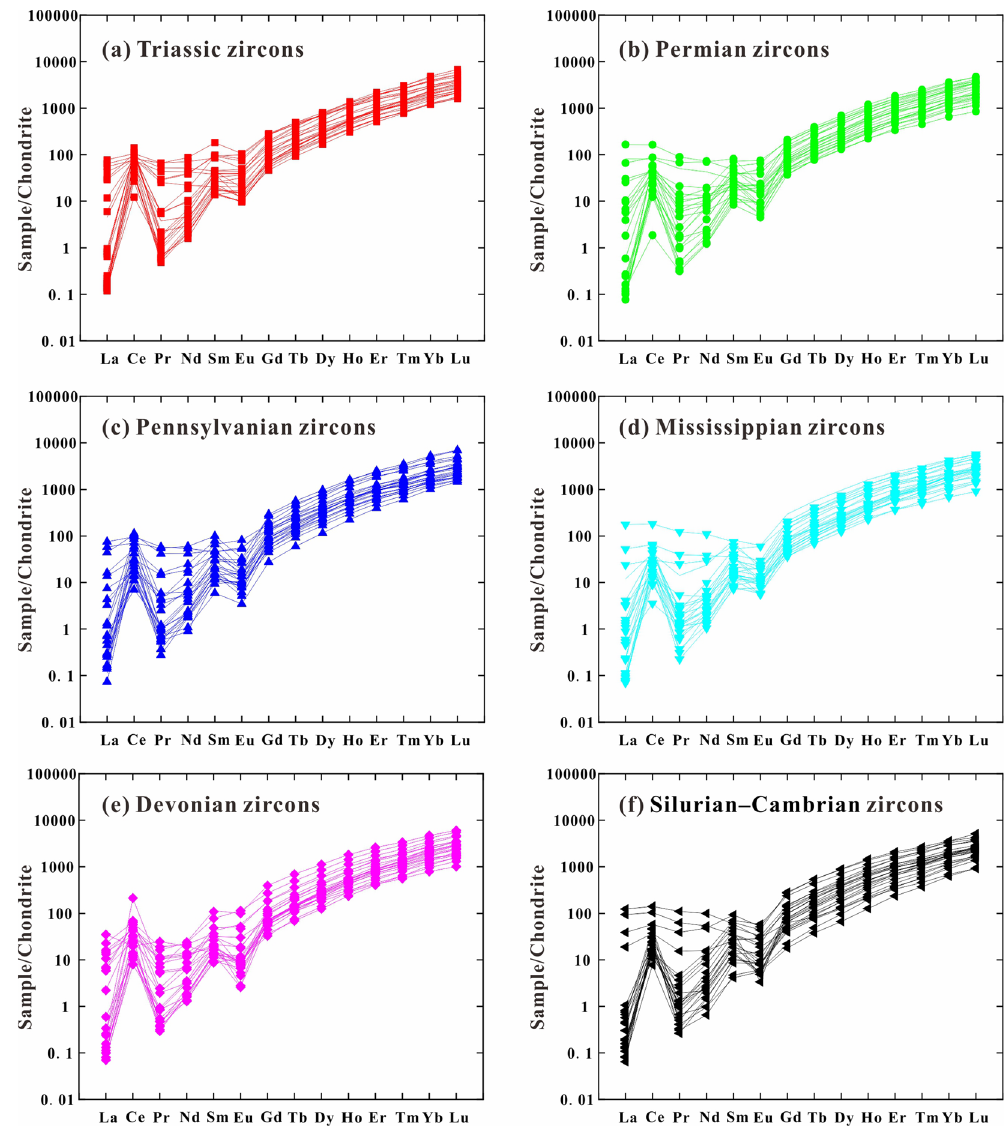
Figure 6. Chondrite-normalized REE patterns for the (a) Triassic, (b) Permian, (c) Pennsylvanian, (d) Mississippian, (e) Devonian, and (f) Silurian–Cambrian zircon grains. Chondrite values are from 59